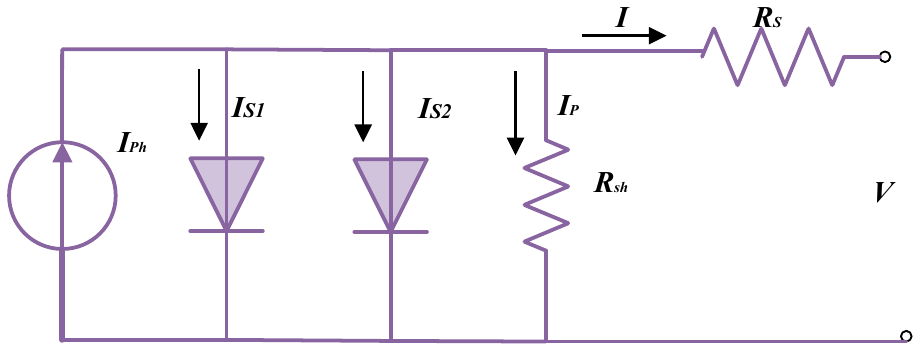
Figure 3. The electrical circuit of the double-diode model.